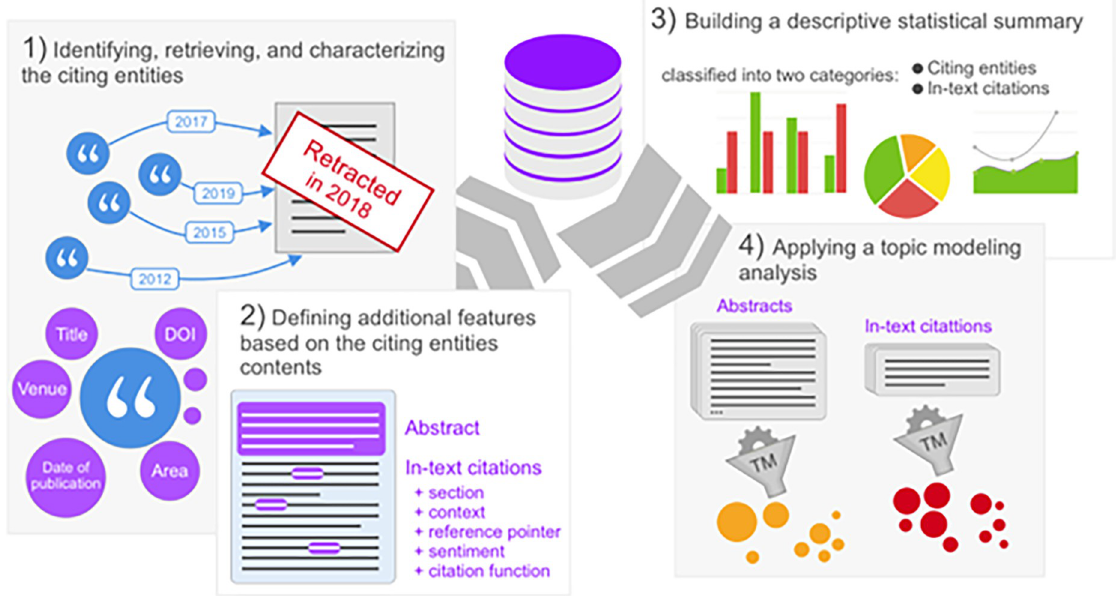
Fig 1. A graphical schema representing the methodology in its four phases (form left to right): (1) identifying, retrieving, and characterizing the citing entities, (2) defining additional features based on the citing entities contents, (3) building a descriptive statistical summary, and (4) applying a topic modeling (TM)